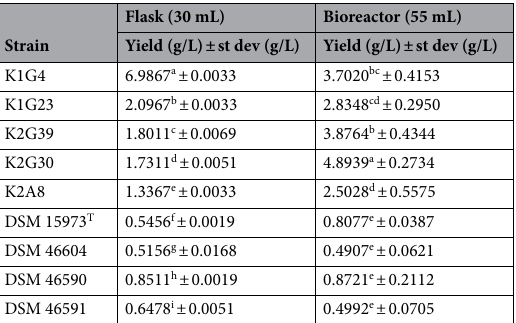
Table 2. Dried BC yield (g/L) produced after incubation at 28 °C for 7 days inside flasks and bioreactor. Values are given as mean ± standard deviation (n = 3). Different lowercase letters in the same column indicate significant differences (p <